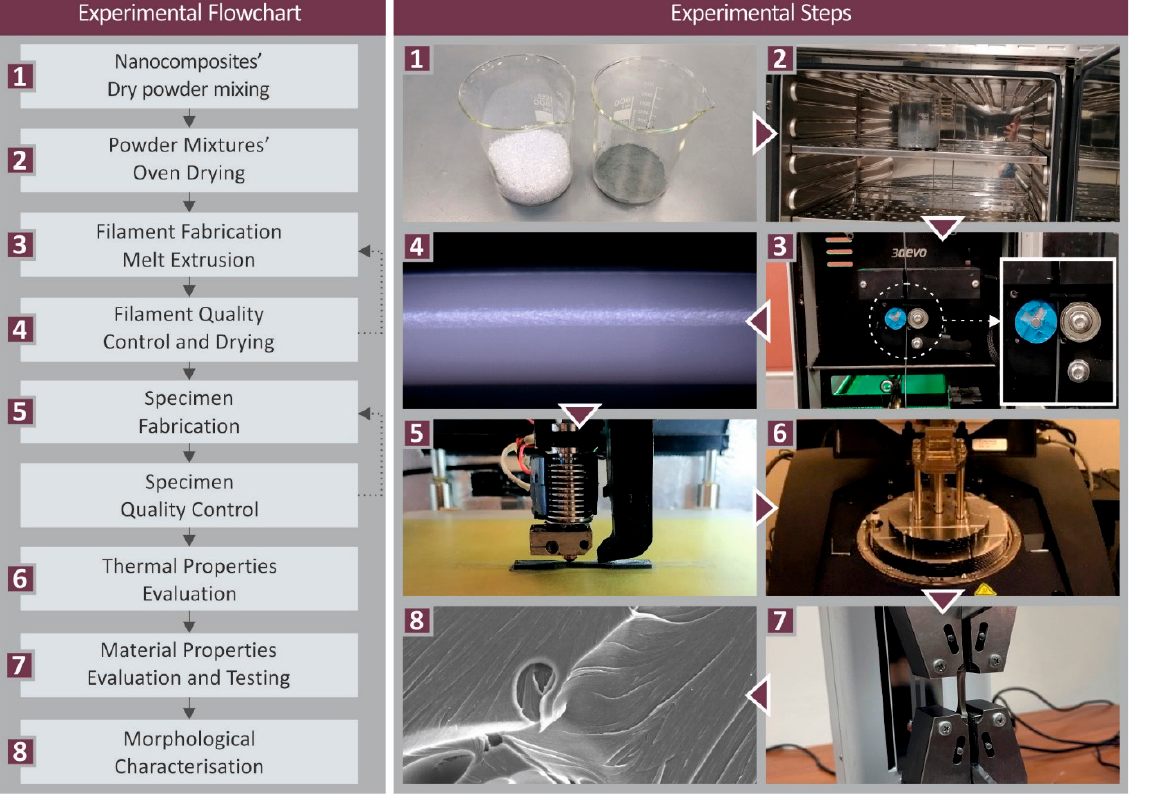
Figure 1. Methodology of the current work.